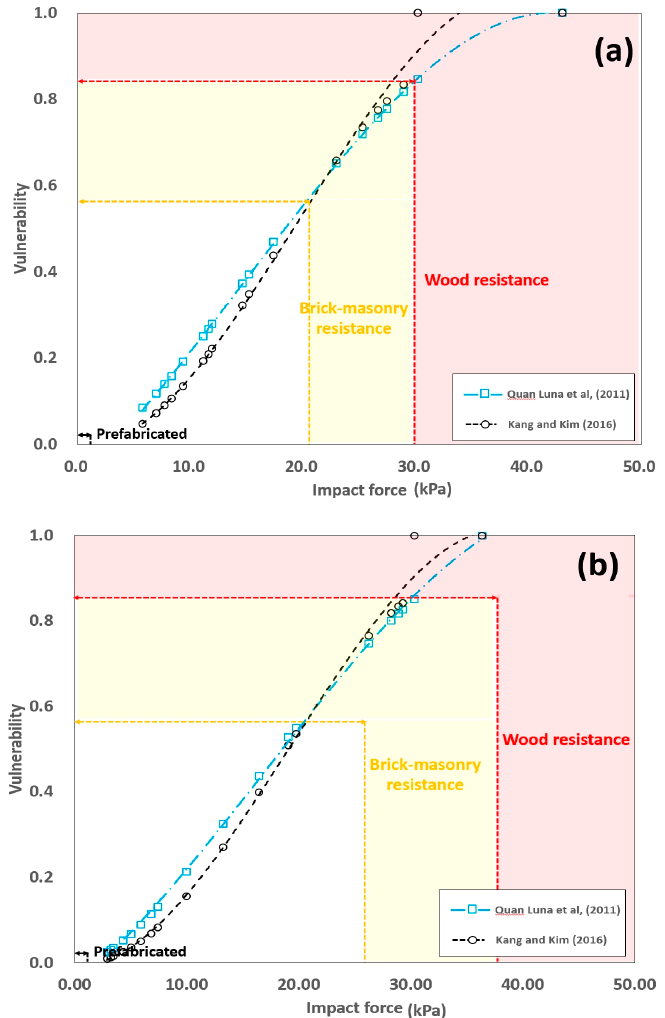
Figure 6. Calculation of vulnerability indexes using vulnerability Equations (8)–(11), based on the debris flow impact forces provided by Equation (7) (blue line for Quan Luna et al. (2011); black dotted line for Kang and Kim (2016); and red line and orange line for vulnerability against the resistance of wood material and brick-masonry material, respectively) ( a ) Site A for the Chuncheon-shi area and ( b ) Site B for the Cheongju-shi area.